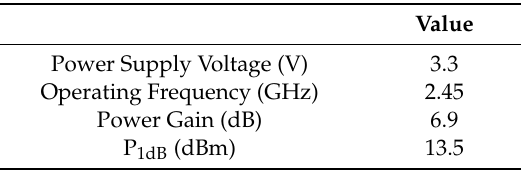
Figure 12. Scheme of the Power amplifier circuit used as a CUT. Greyed region indicates components integrated in the IC. integrated in the IC. Table 3. Power amplifier Table 3. Power amplifier performance.